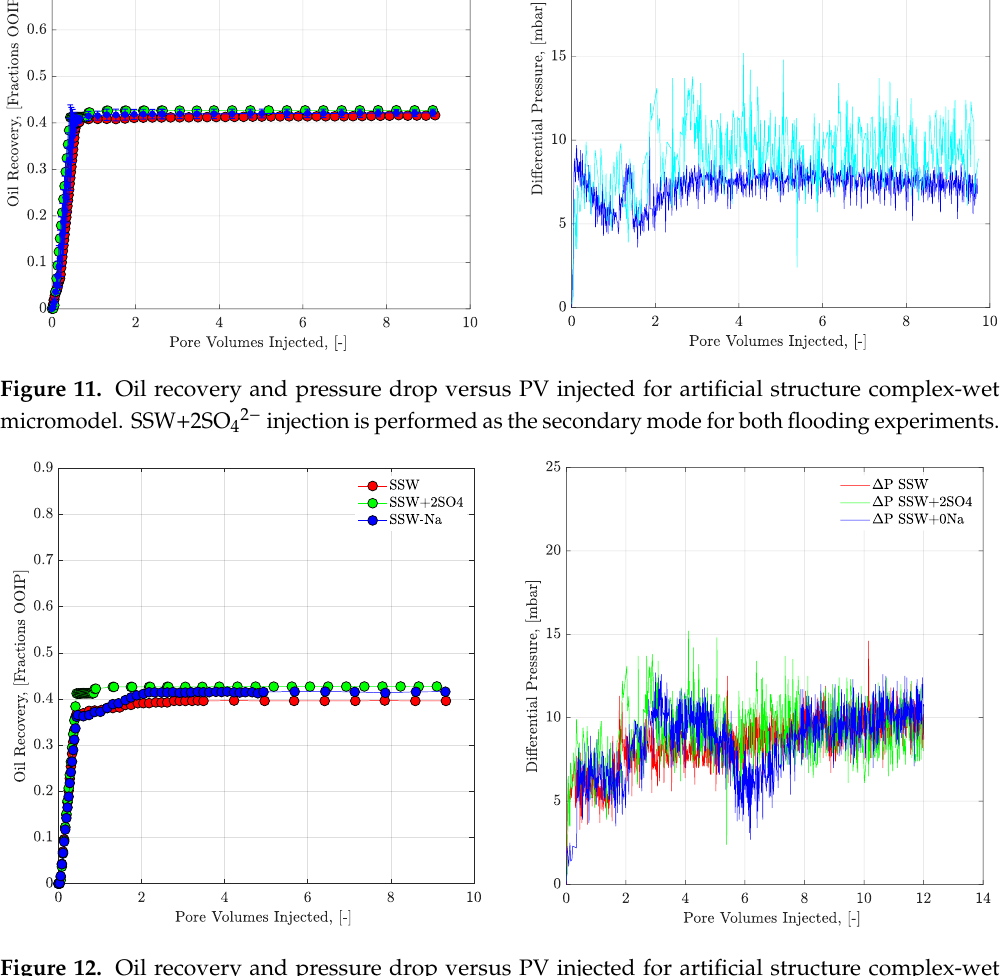
Figure 12. Oil recovery and pressure drop versus PV injected for artificial structure complex-wet micromodel. Three injection brines of Table 2 are flooded as the secondary mode.